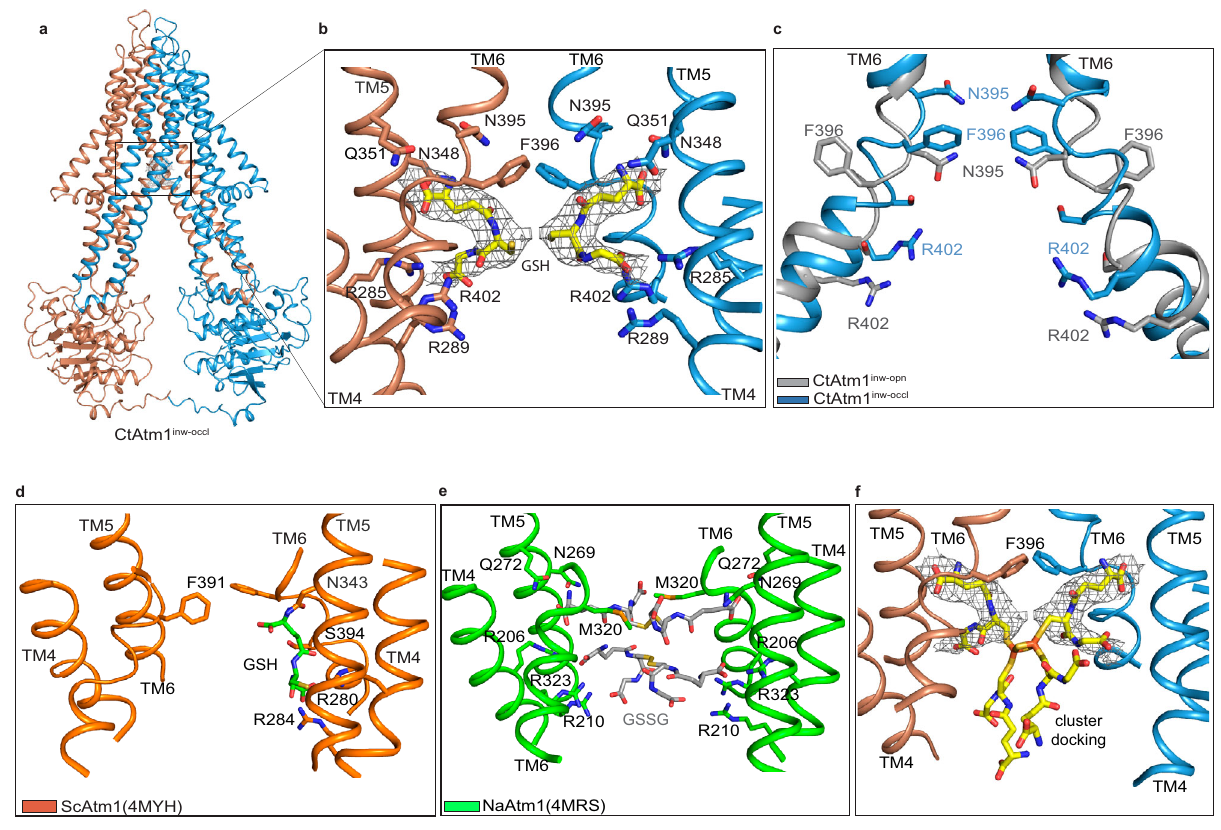
Fig. 3|Theinward-facingpartiallyoccludedstructurewithboundcargo.a The inward-facing partially occluded structure with bound cargo, CtAtm1 inw-opn-occl , with the cryo-EM density of bound cargo (gray) and the protein colored as in Fig. 1d. b Close-view of thecargobinding site.The cryo-EMdensityofthecargois shownin gray and the modeled glutathione (GSH) molecules as yellow sticks. Asn395 and F396and residues involved in cargo binding are also shownassticks. c Comparison